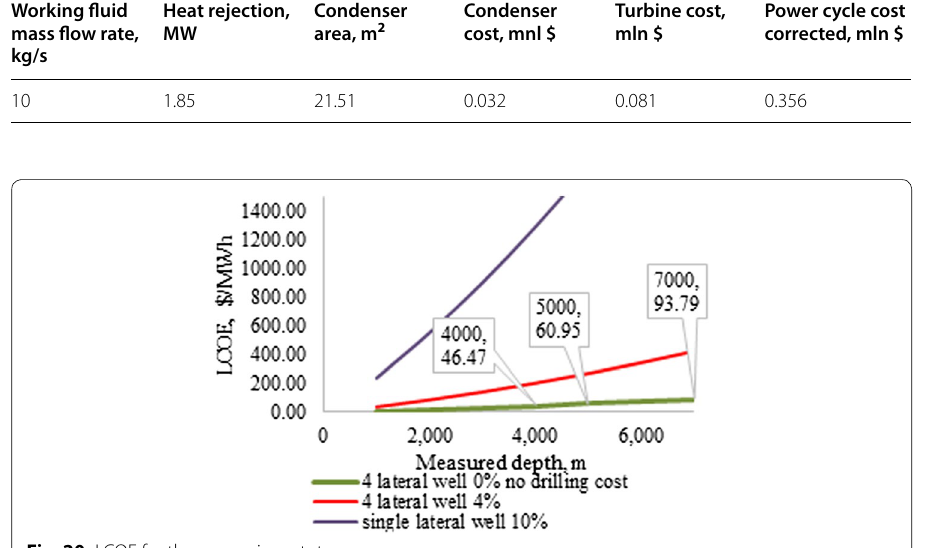
Fig. 20 LCOE for the reservoir-prototype case